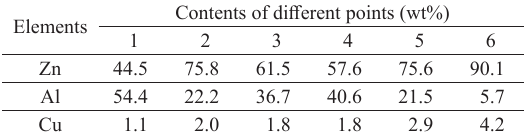
Table 2. Elements content in different